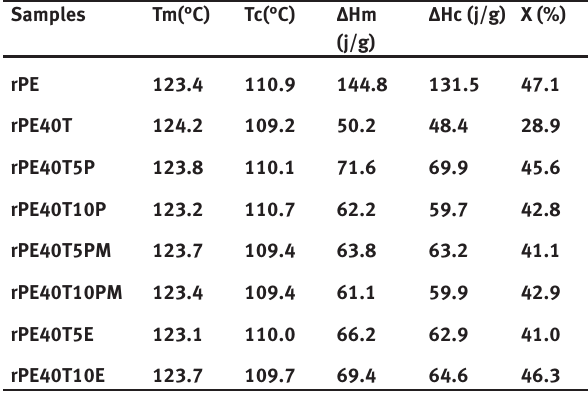
Table 2: DSC results of the control sample and compatibilized